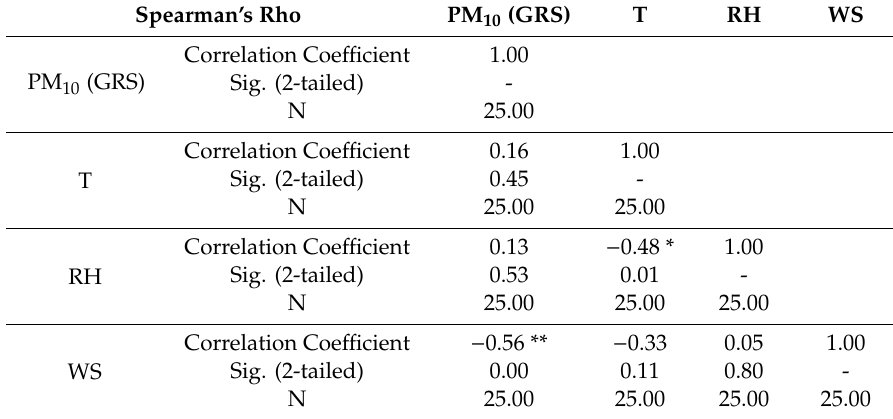
Table 2. Spearman correlations of ambient (GRS) PM 10 , air temperature (T), relative humidity (RH) and wind speed (WS) for all experimental days.